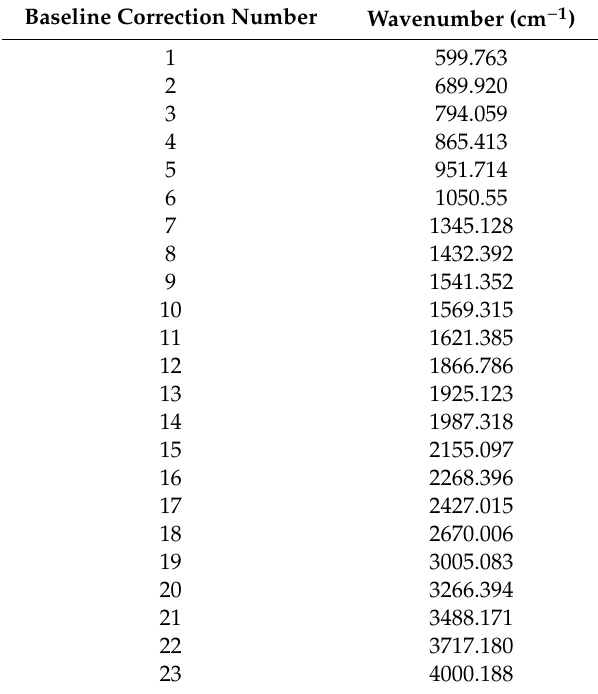
Table A1. Exact wavenumbers for the baseline correction.